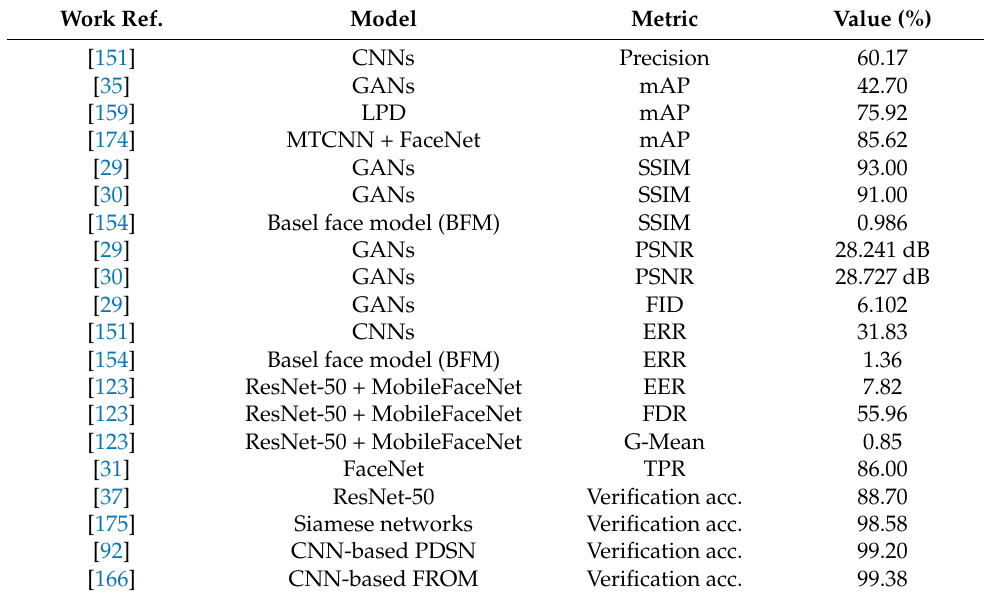
Table 7. A comparison of other evaluation measures achieved by MFR approaches. Work